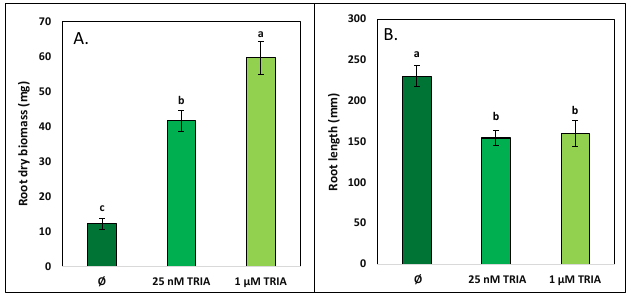
Fig. 2: Effects of two concentrations (25 nM and 1 μM) of triacontanol (TRIA) on the root dry biomass (A.) and root length (B.) of spinach (Ø stands for the control group). Vertical bars represent ± standard error from means (n=5), different letters above the columns indicate significant differences at P < 0.05 (Tukey’s HSD test)